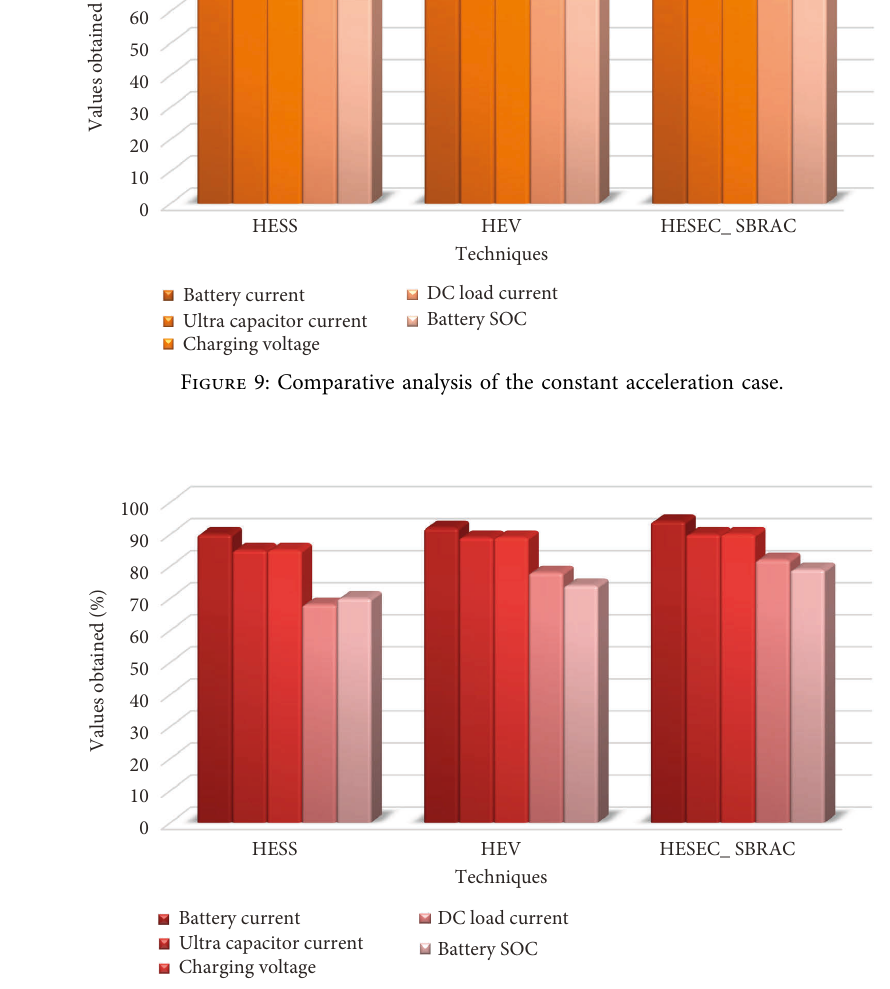
Figure 10: Comparative analysis of the constant acceleration case.